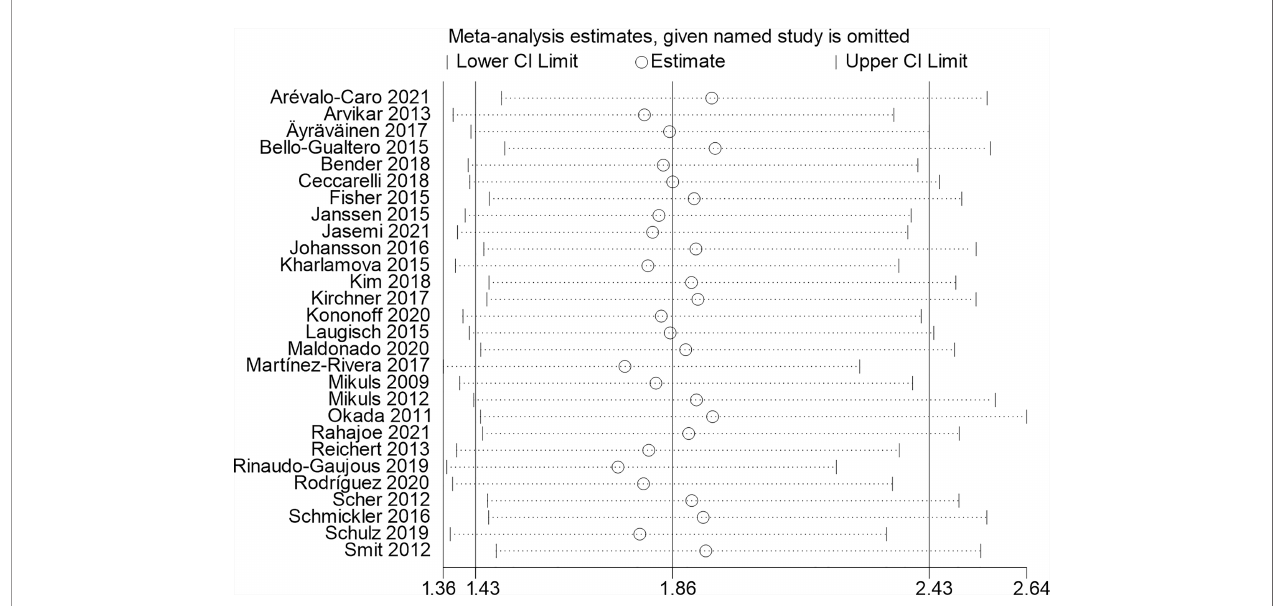
FIGURE 4 | Sensitivity